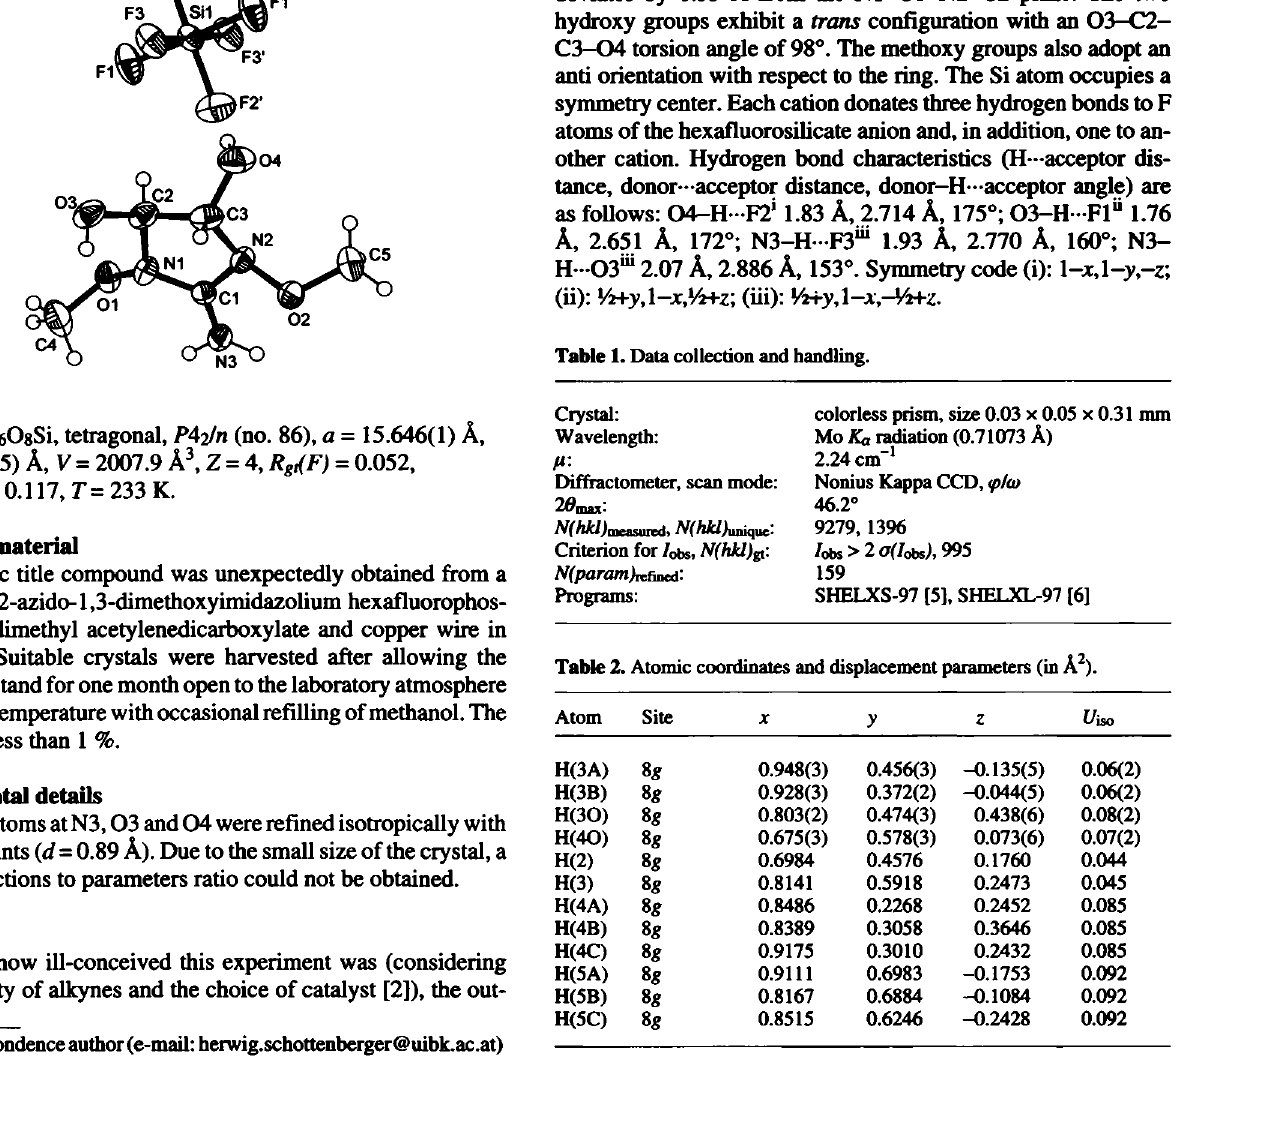
Table 1. Data collection and handling.